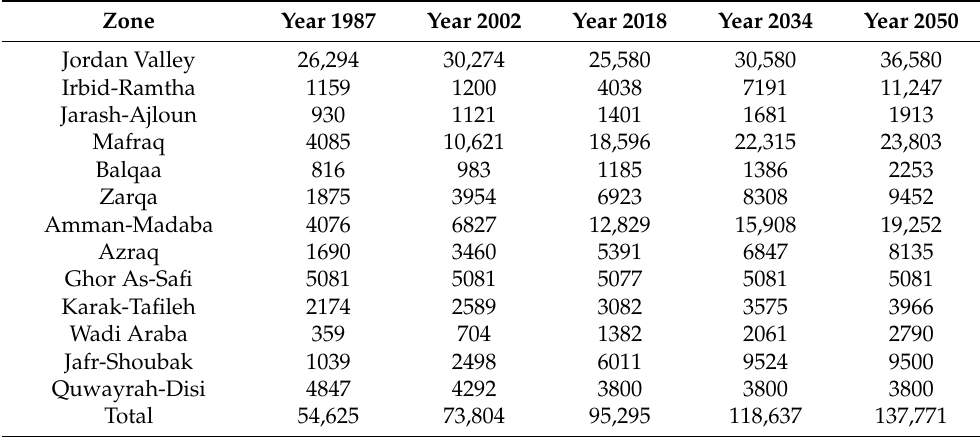
Table 6. Summary of irrigated areas (ha) in Jordan during 1987–2019 and in the